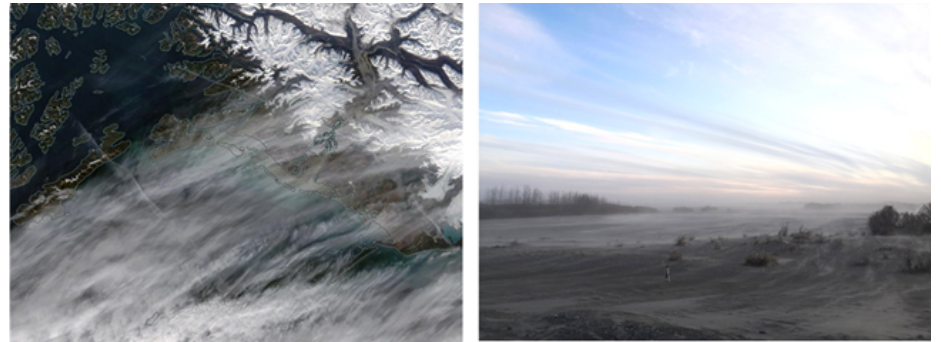
Figure 5. Satellite image (left) of the Copper River region and photo (right) taken at the Copper River Delta on the same day (14 October 2019). The common occurrence of clouds prevents direct viewing of the dust in suspension, illustrating the difficulty in observing dust activity from space. (Satellite image from NASA Worldview; photo by Sarah